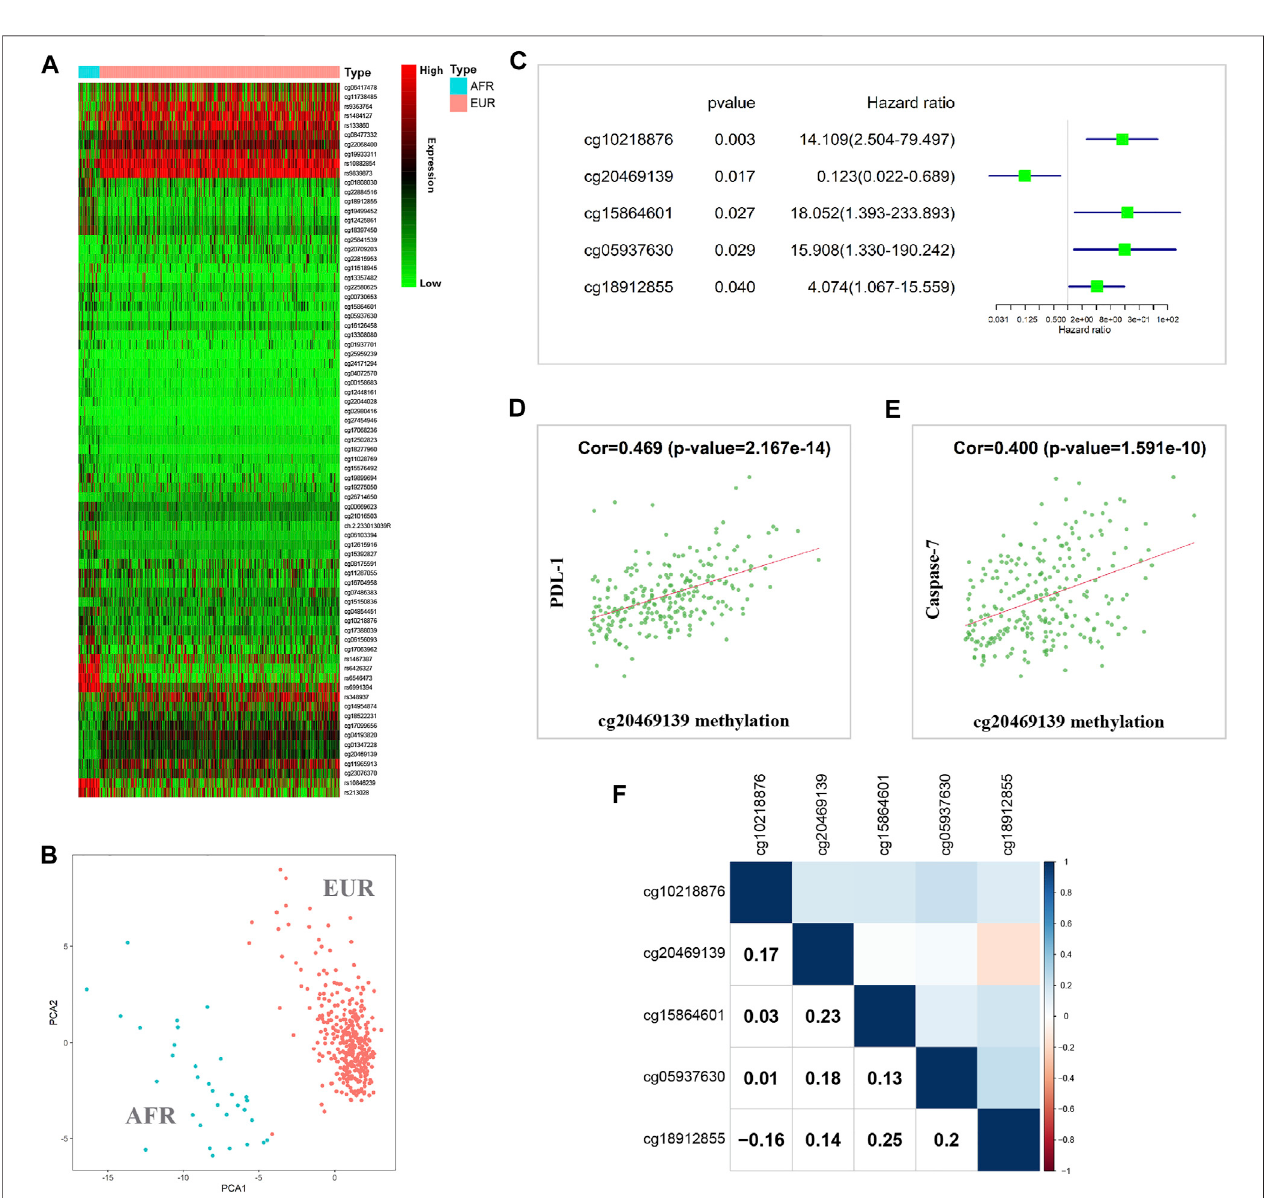
FIGURE 4 | Methylation differences between EUR and AFR OSCC patients. (A) Heat map of differentially methylated sites between the EUR and AFR ancestries. (B) Differentially methylated sites can effectively differentiate patients of EUR and AFR ancestries. (C) Five differentially methylated sites were associated with the prognosisofOSCCpatients. (D) Thedegreeofmethylationofthecg20469139sitewassigni fi cantlycorrelatedwiththePDL-1level. (E) Thedegreeofmethylationatthe cg20469139 site was signi fi cantly correlated with the caspase-7 level. (F) Correlations between the methylation levels of the fi ve survival-related loci.